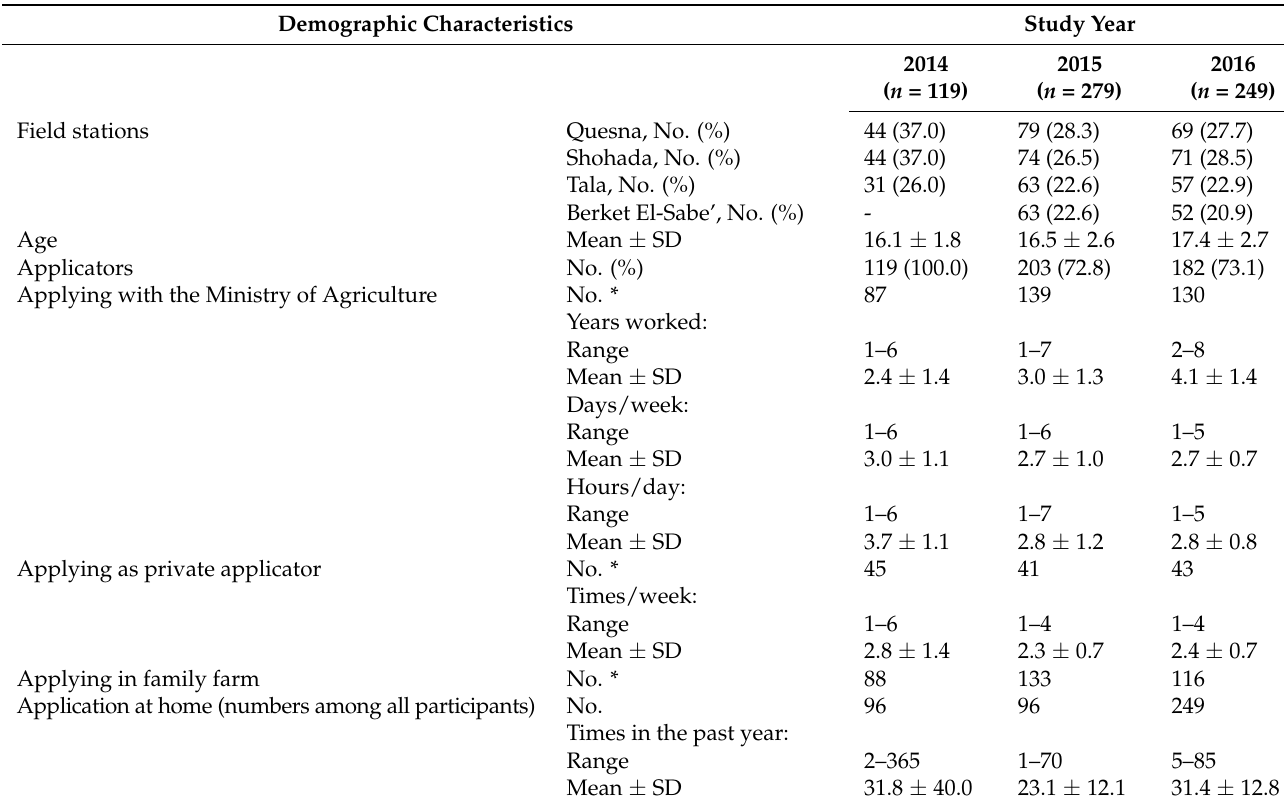
Table 1. Distribution and demographic characteristics of the study participants across the 3 years of study (from base- line questionnaires).